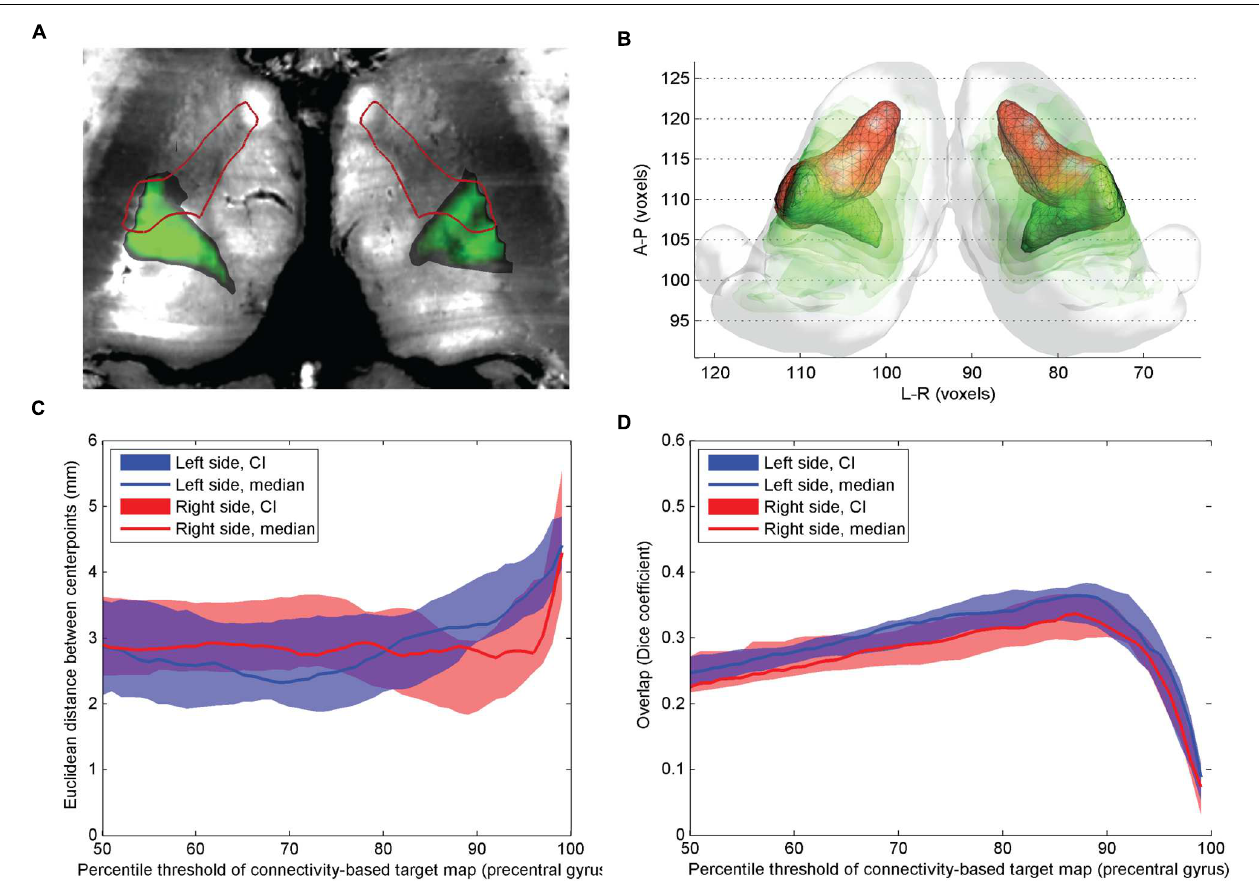
FIGURE 2 | Comparison of atlas based VL pv nucleus and CBT using precentral gyrus connections. (A) Cross-sectional image derived from histological sections, in standard space (Big Brain Atlas, Amunts et al., 2013) with VL pv overlaid (red outlines) and the CBT from the precentral gyrus (green color scale) ; (B) 3D visualization of the CBT and atlas targets: connectivity-based targets were visualized in green color with different opacities reflecting to the summed probability across the study population (50–95th percentile range) while the VL pv was depicted in red 3D mesh ; (C) Euclidian distance of the center-of-gravity of the CBT to the atlas based target: dependency on the applied threshold values; (D) volumetric overlap with atlas based targets: dependency on the applied